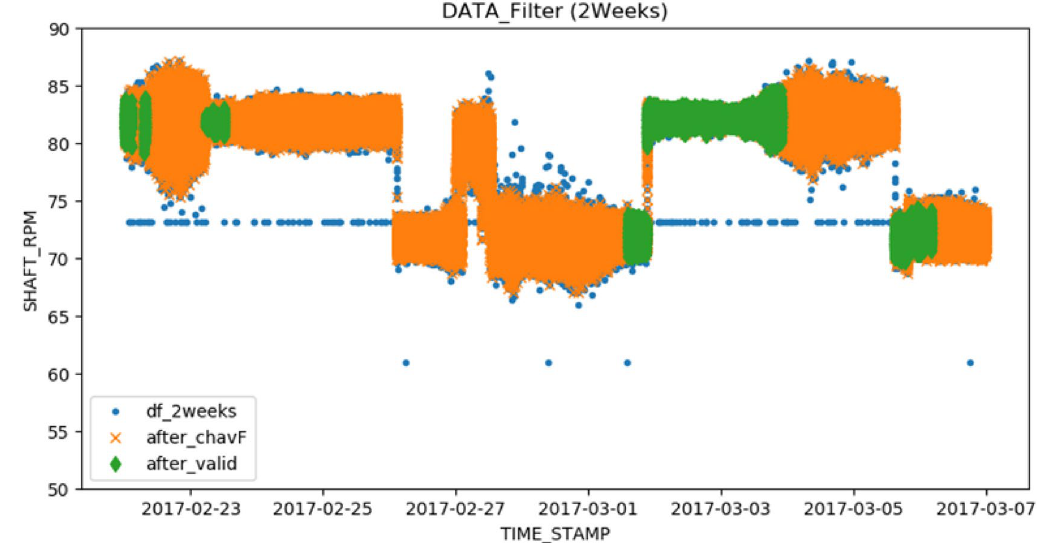
Figure 6. Sample plot of the measured data and validated data for 2 weeks.